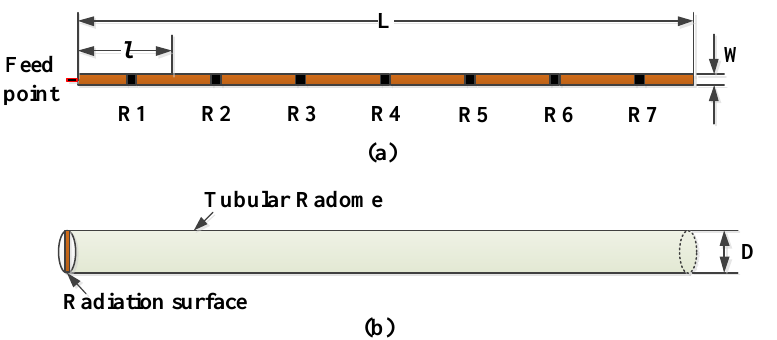
Figure 1. Geometry of the antenna. ( a ) Antenna radiation surface and resistance distribution. ( b ) Antenna arm structure. The structural parameters of the antenna are as follows: L = 1350 mm, l = 193 mm, w = 10 mm and D = 12 mm.